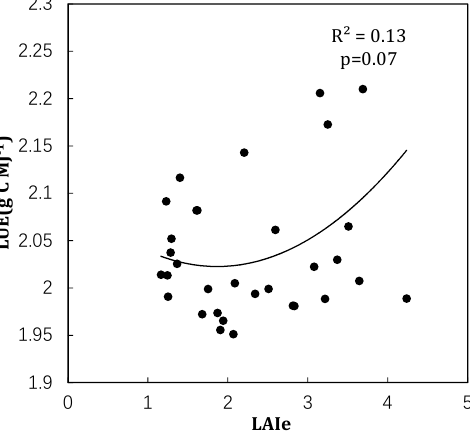
Figure 9. The relationship between AMSPEC-PRI predicted LUE and LAI e , which were extracted from TLS point cloud in different VAA s .